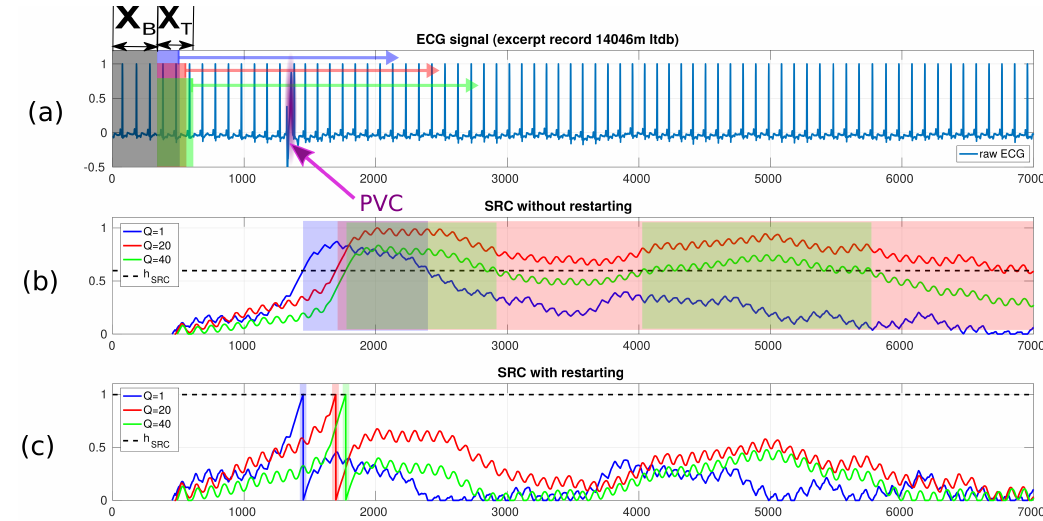
Figure 3. Whilst monitoring the ECG signal ( a ), restarting the SRC each time the threshold was hit ( c ) is indicated to avoid potentially lengthy delays before the anomaly propagates through and clears X T ( b